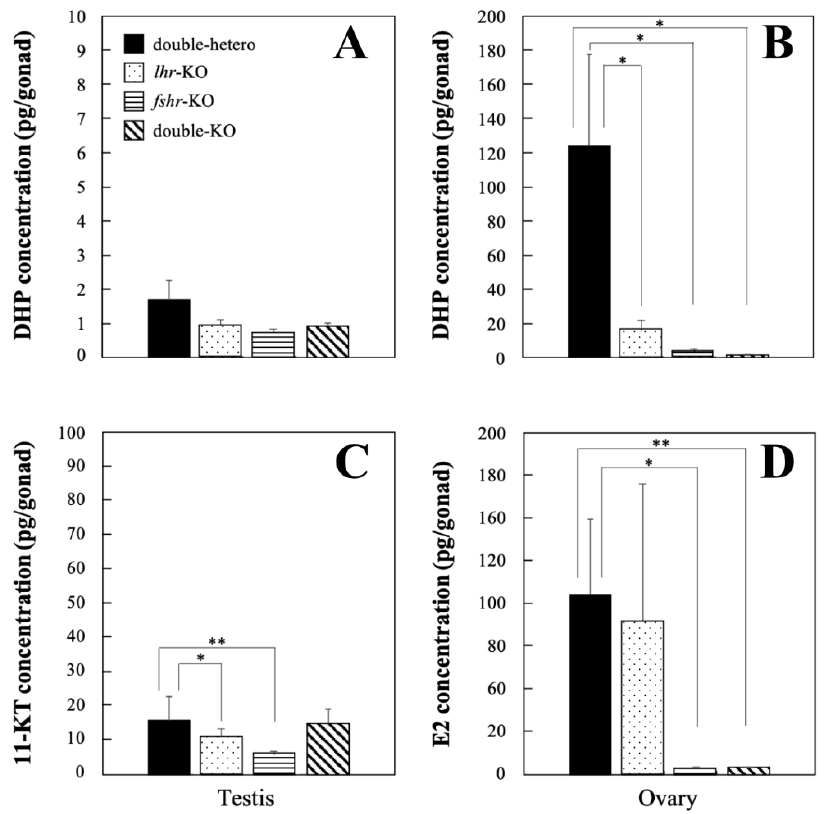
Figure 4. DHP concentration in double-hetero, lhr -KO, fshr -KO, and double-KO male ( A ) and female ( B) medaka. 11-KT concentration in male testes ( C ) and E2 concentration in female ovaries ( D ) in double-hetero, lhr -KO, fshr -KO, and double-KO medaka. Steroid hormones were extracted from gonads of adult medaka. Vertical bar indicates ± SEM ( n = 3). * p < 0.05, ** p < 0.01.